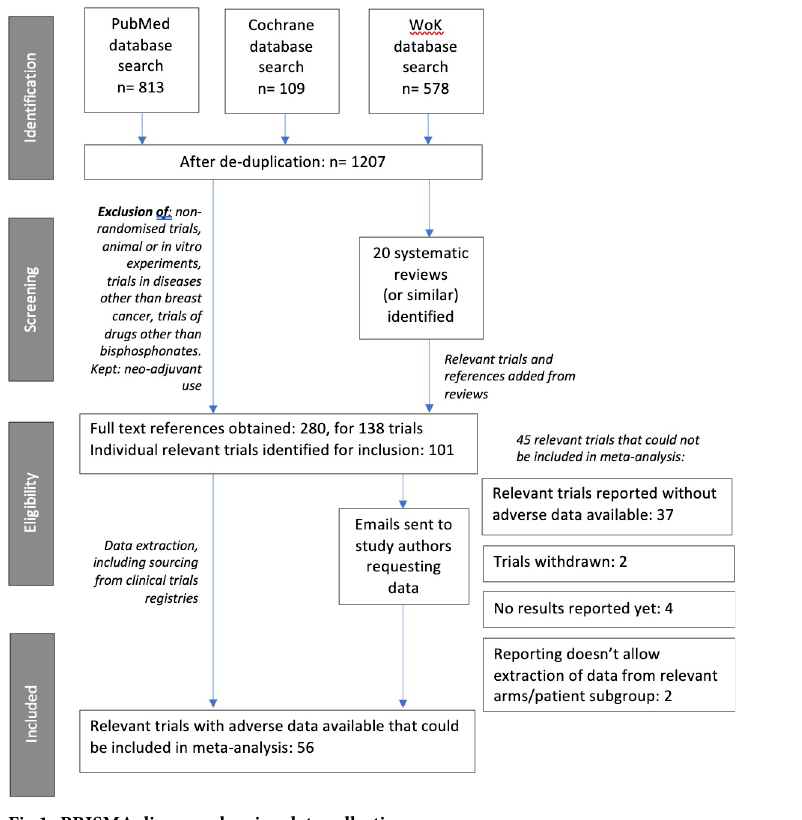
Fig 1. PRISMA diagram showing data collection